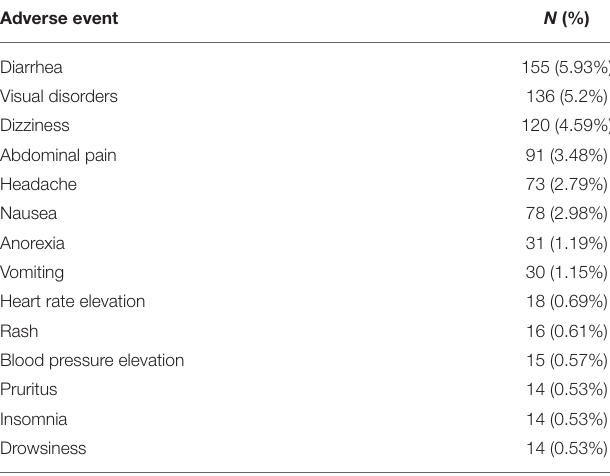
TABLE 2 | Safety analysis among subjects receiving ivermectin ( n 2,613).